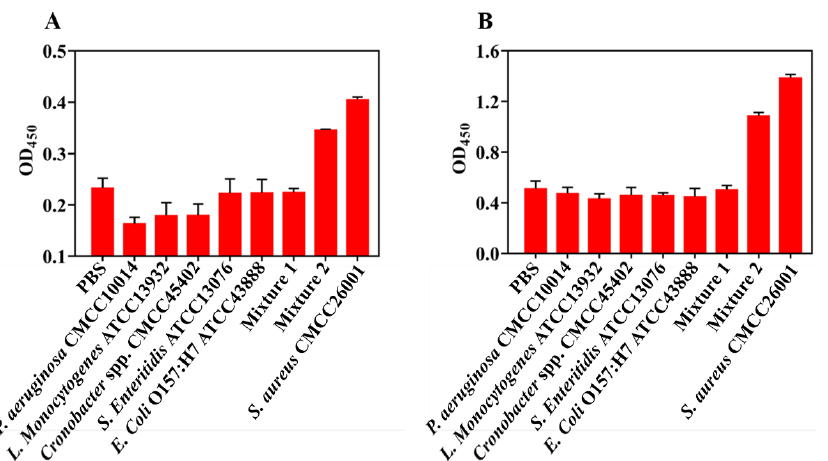
Figure 5. The specificity of common colorimetric and AMS-DNFs detection method. ( A ) The specificity of common colorimetric detection method for S. aureus and non-target bacteria. ( B ) The specificity of the AMS-DNFs amplification colormetric detection method for S. aureus and non-target bacteria. The concentration of non-target bacteria was 10 7 CFU/mL.